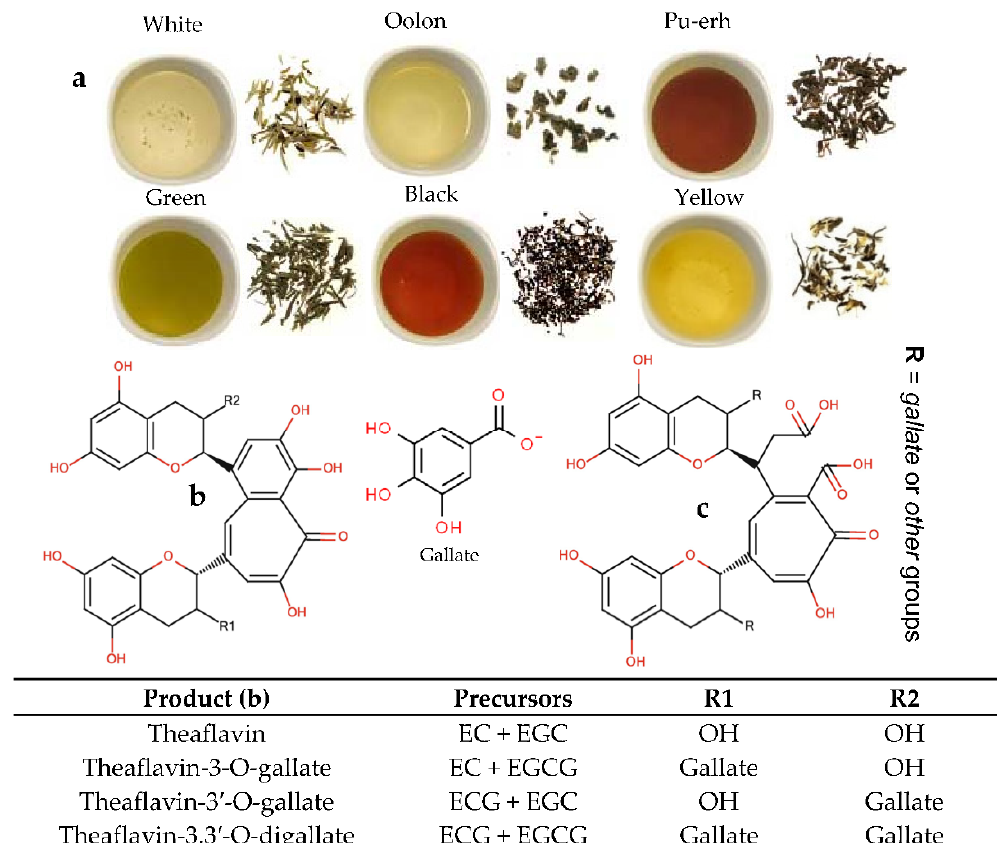
Figure 1. Images of different tea types ( a ) and chemical structures of theaflavins ( b ) and thearubigins ( c ) present in black tea. EC: epicatechin, EGC: epigallocatechin, ECG: epicatechin gallate, EGCG: epigallocatechin gallate.